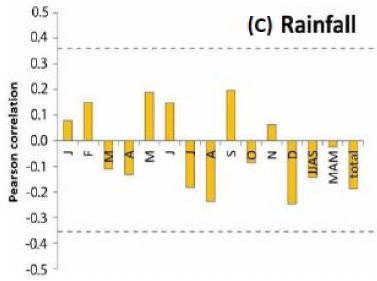
Figure 8. Correlation coe ffi cients ( n = 22) between monthly and seasonal climate variability and tree-ring width of Erica arborea (1992–2013). ( A ) Maximum temperature; ( B ) minimum temperature; ( C ) rainfall. The dotted line represents the p < 0.1 level. Significant correlations are indicated with a black